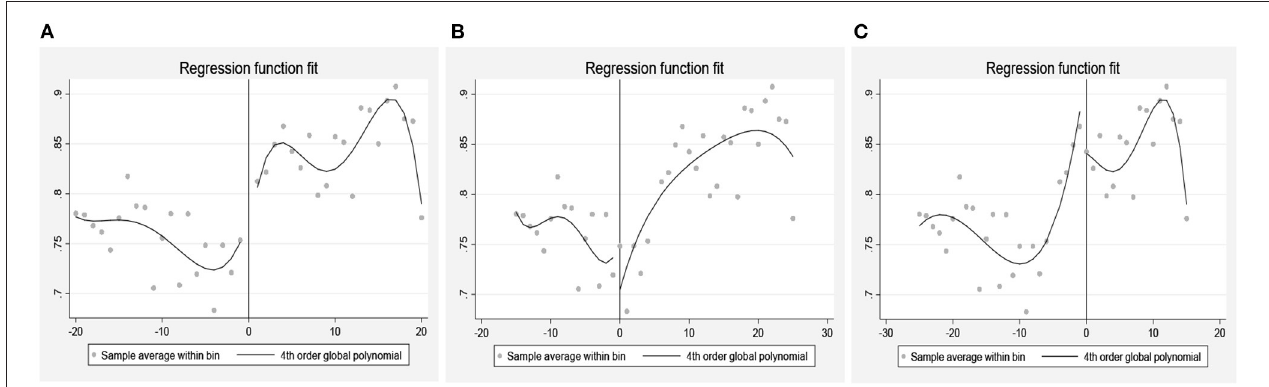
FIGURE 4 | (A) The effect of retirement on happiness when 60 is the retirement age. (B) The effect of retirement on happiness when 55 is the retirement age. (C) The effect of retirement on happiness when 65 is the retirement age.